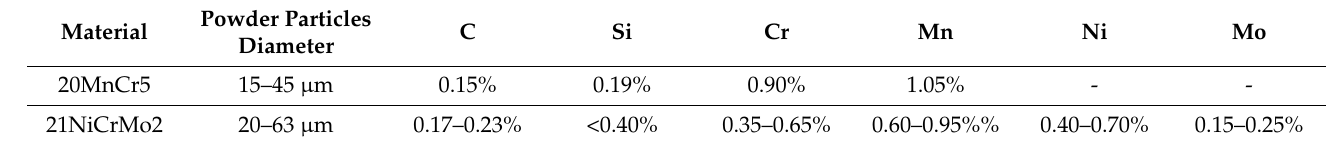
Figure 3. Half on the specimen with a honeycomb cell structure (PH Samples).